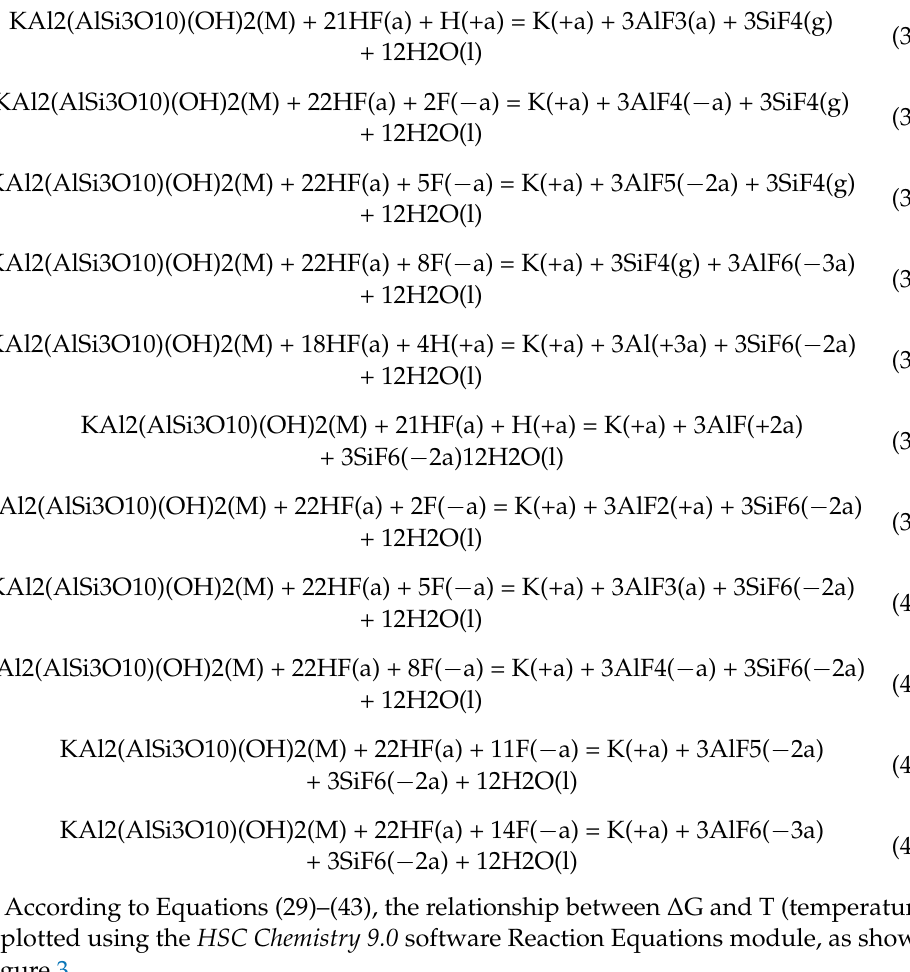
[3CaO·2(Al 2 O 3 ,Cr 2 O 3 ,V 2 O 3 )·3SiO 2 ]. It belongs to island silicate minerals that are difficult to leach. Because vanadium in island aluminosilicate minerals exists in the form of a homo- geneous phase replacement and is more stable, the crystal structure of a garnet is difficult to destroy. A total of 21.1% of vanadium (Table 3) in original samples is distributed in garnet. Consequently, leaching aids were added to strengthen the acid leaching process to help release vanadium. Therefore, the acid-leaching process intensification was verified by calculating the relevant thermodynamic parameters of garnet. The dissolution reaction of Al and V has been described in detail in the previous section, so it is not described here. In addition, the relevant electrochemical reaction of Ca in an aqueous solution is relatively simple and is not explained here. This section mainly describes the dissolution reaction of Cr. Dissolution Reaction of Chromium The electrochemical reaction equation of chromium in an aqueous solution is shown in Table 3. Under the conditions of 25 °C and 1 bar, the Eh-pH diagram of the Cr-H 2 O system was obtained according to the main equations listed in Table 3 and HSC Chemistry 9.0 software. The detailed calculation results are shown in Figure 4. It can be seen from Figure 4 that Cr in the Cr-H 2 O [22,23] system is in the immunity area, its reducibility is strong, and it is easy to replace H + . When Cr appears in an aqueous solution in the form of Cr 2+ , it is in the stable area of Cr 2+ and H 2 . As a result, hydrogen